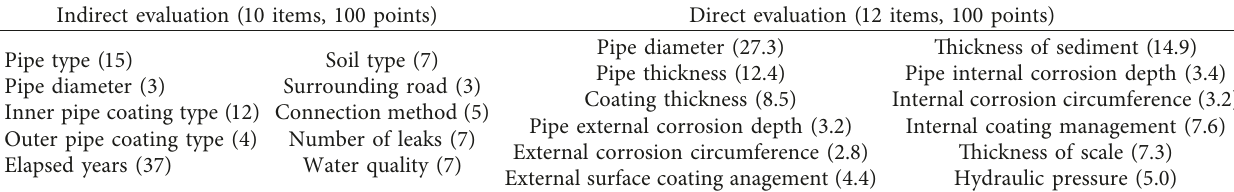
Table 3: MOE’s evaluation index for deteriorated pipes.